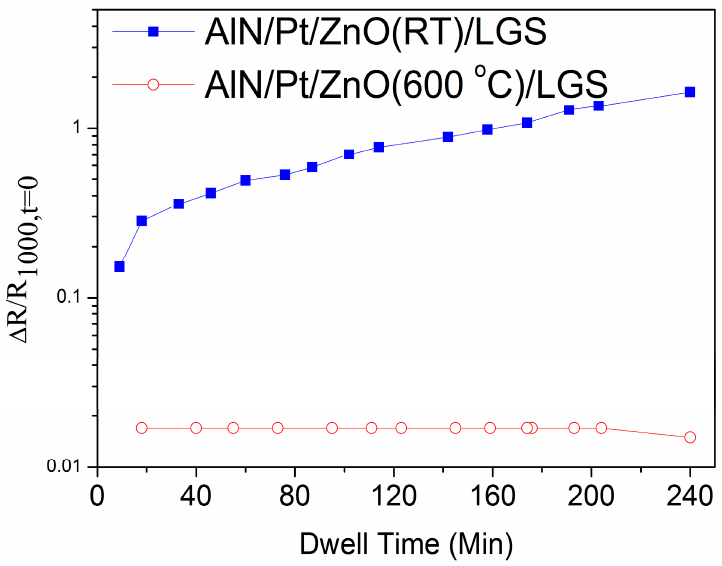
Figure 7. Relative resistance change of AlN/Pt/ZnO(RT)/LGS and AlN/Pt/ZnO(600 °C)/LGS samples as a function of time at 1000 °C for 4 h.